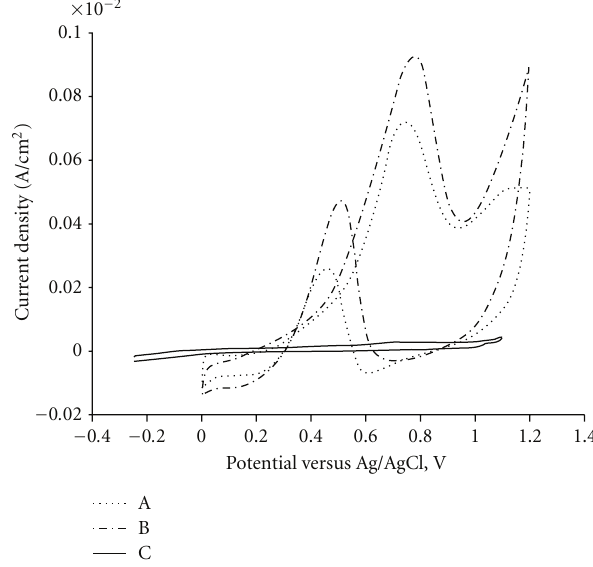
Figure 6: Study of cyclic voltammetry of diamond films with electrocatalyst deposition on 0.1 MeOH/0.5 m H 2 SO 4 at 50 mVs − 1 : (A) Pt/BDD, (B) Pt-Ru/BDD, and (C) BDD (reprinted with permission from